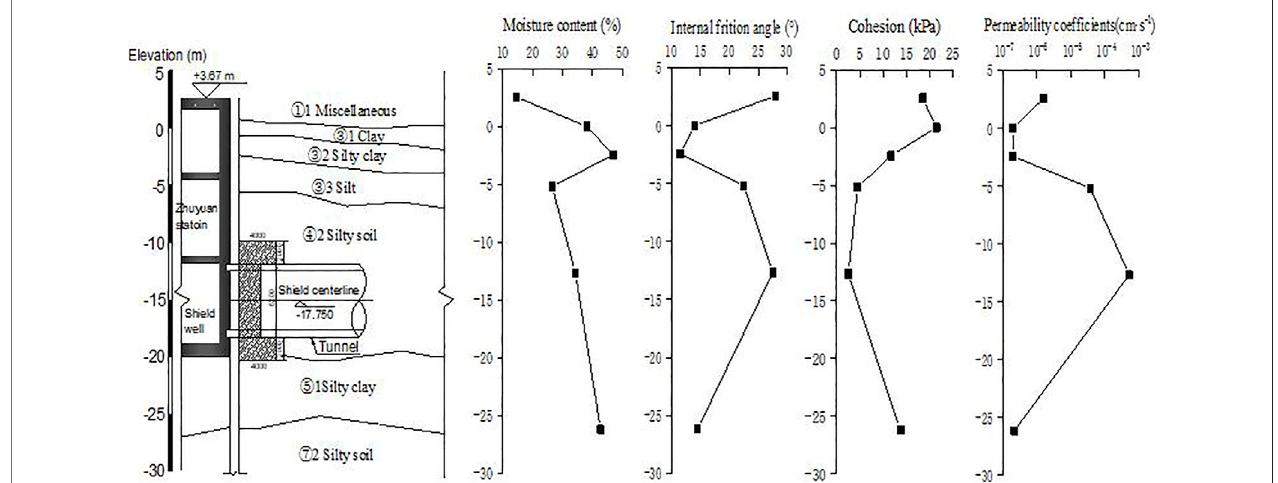
FIGURE 2 | Soil distribution in shield well area.